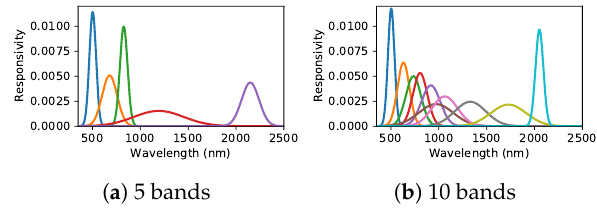
Figure 11. Bands extracted from Land cover classification dataset.